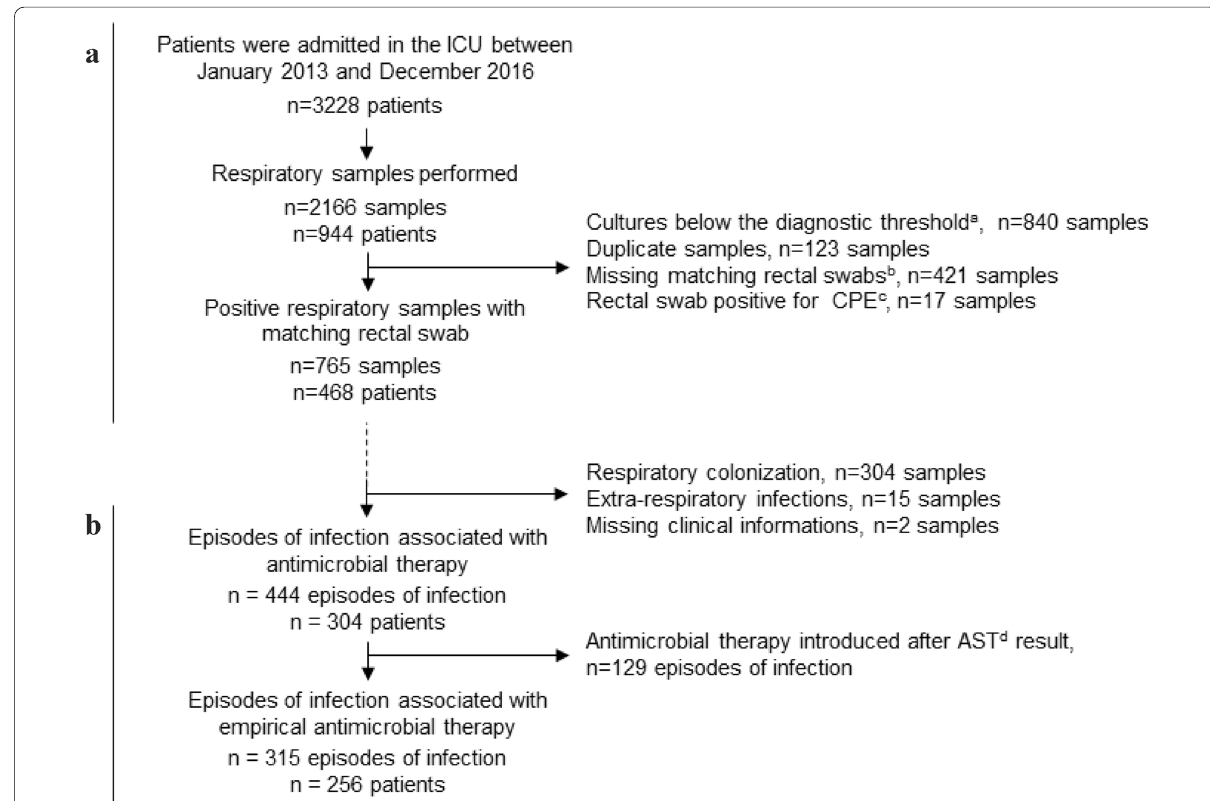
Fig. 1 Flow chart of patients included in the study. a Data used to test the performances of rectal colonization surveillance to predict presence of HLAC-E, ESBL-E and 3GCR-E in respiratory samples. b Data used to test the potential impact of rectal colonization surveillance on empirical antimicrobial therapy of pulmonary infections. a Respiratory sample was defined as negative when less than 10 3 colony-forming units (CFU)/ mL were observed in protected distal sampling, 10 4 CFU/mL in BAL, 10 6 CFU/mL in endotracheal aspirates and 10 7 CFU/mL in sputum cultures. b Patients without rectal swab culture available within 21 days before the respiratory sample were excluded. c CPE, carbapenemase-producing Enterobacterales. d AST: antimicrobial susceptibility